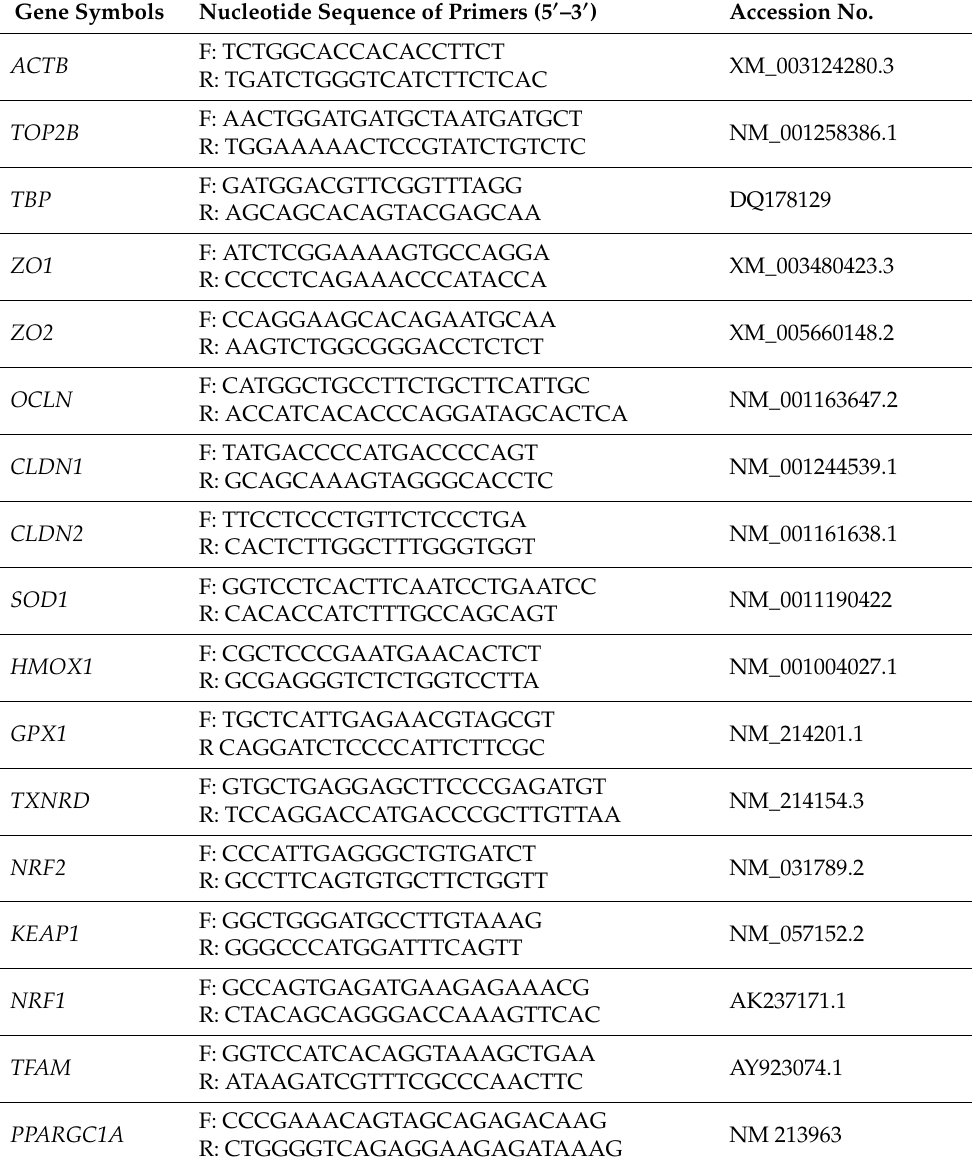
Table 3. Nucleotide sequences of primers used to measure targeted